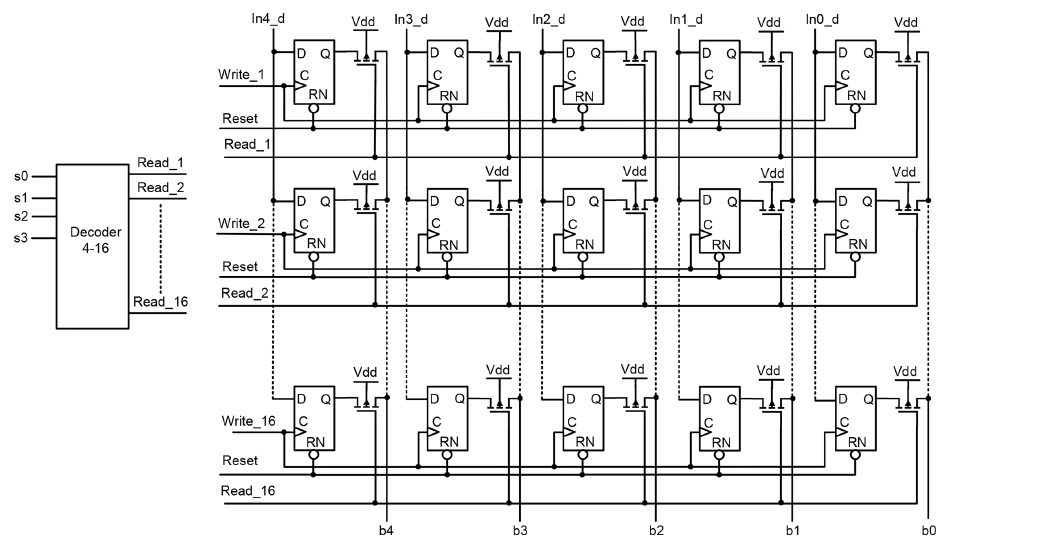
Figure 20. Schematic of the memory. It is used to save the order of the ASRC outputs. The decoder is used to select the word address.